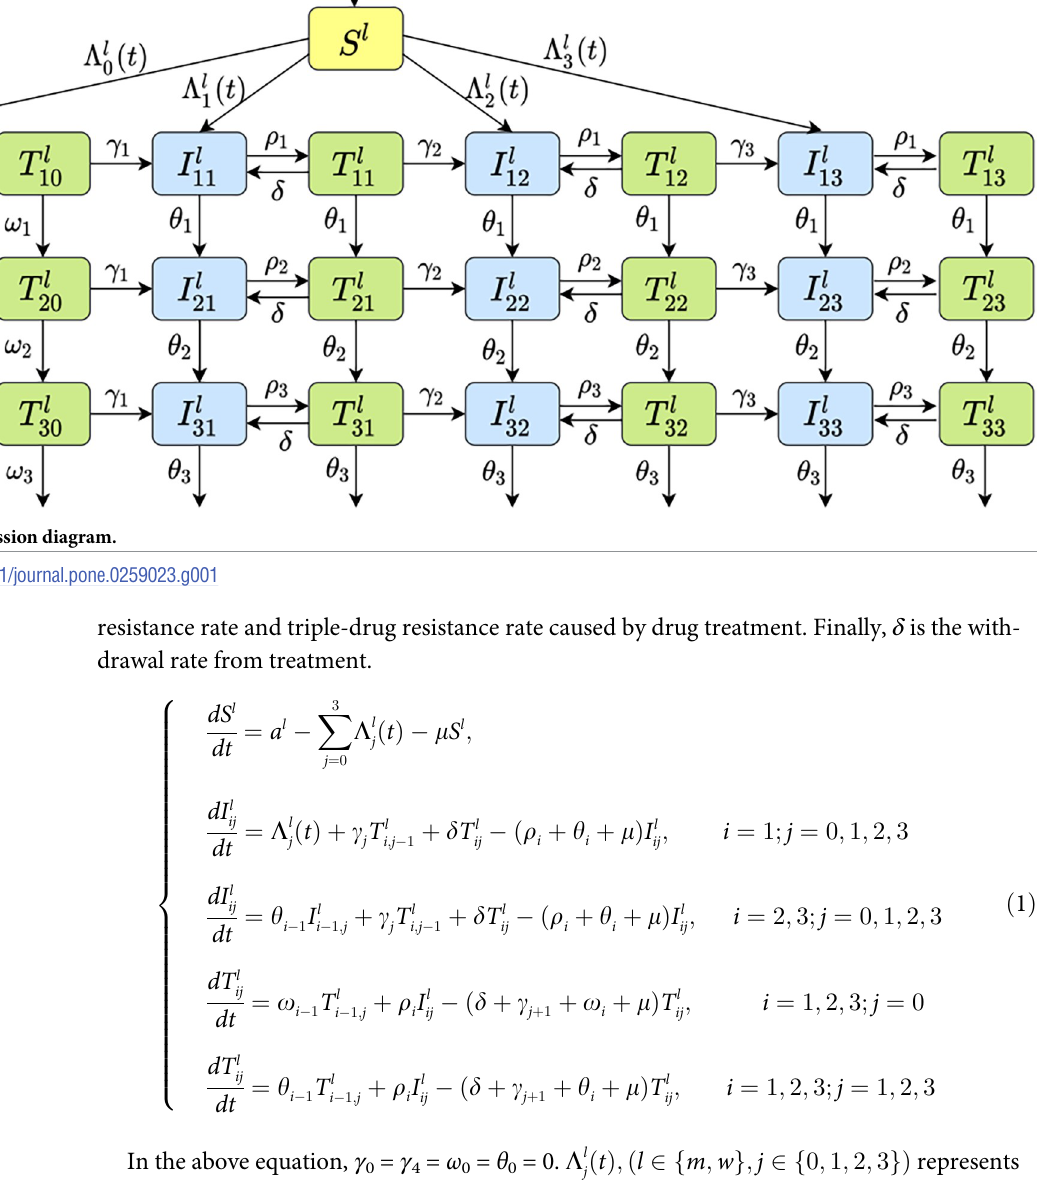
Table 1. Sub-models and corresponding assumptions. Symbols of sub-models Assumptions